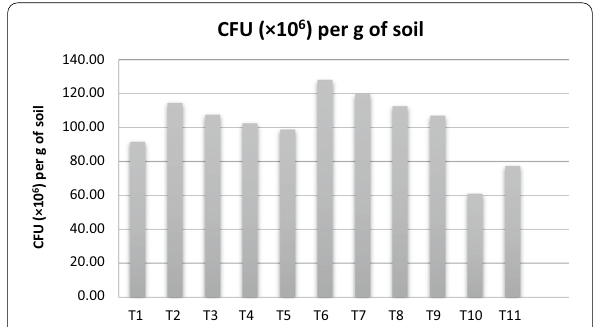
Fig. 5 Effect of microbial formulations on total bacterial count in soil (cfu/g of